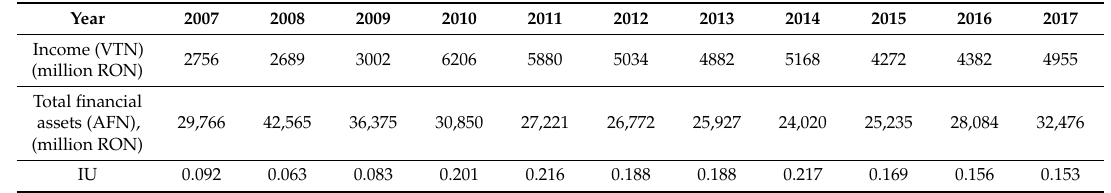
Table 5. Asset user indicator (IU) values for the period